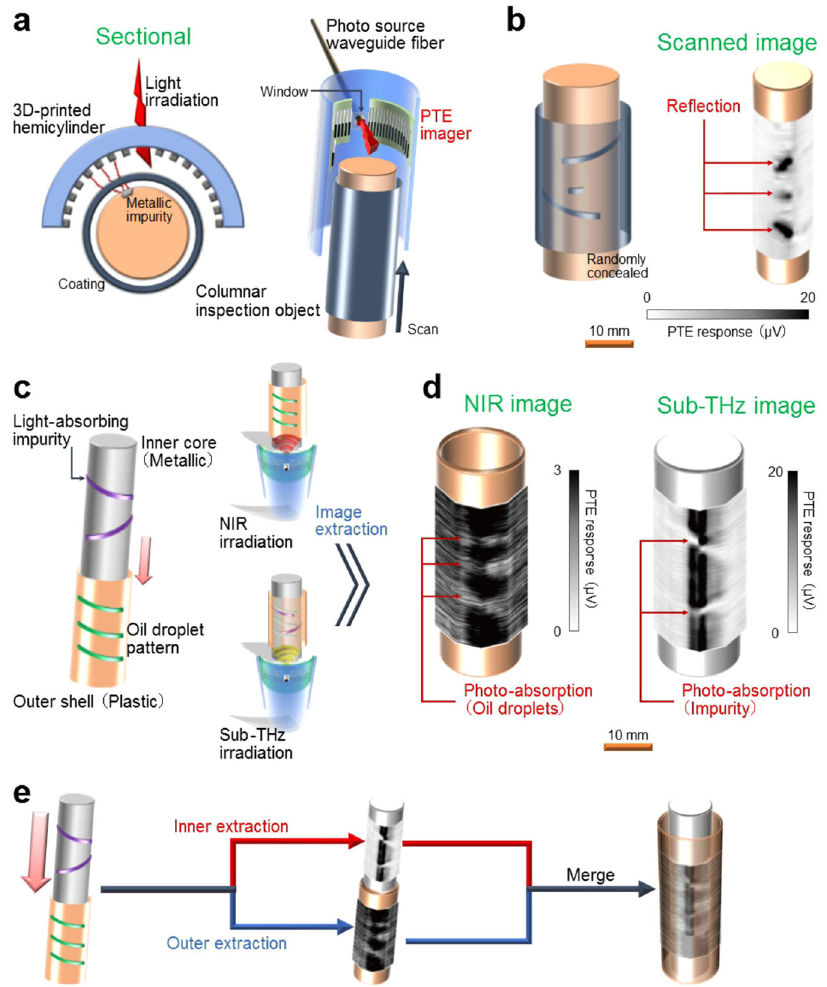
Fig. 2 Re fl ective multi-view stereoscopic capsule photo-thermoelectric (PTE) imager. a Schematic of the module and its fundamental operation mechanism. Operation of the re fl ective multi-view stereoscopic capsule PTE imager of the Methods section describes the corresponding detailed conditions. b Non-destructive re fl ective multi-view stereoscopic capsule photo-imaging inspection of a glass beverage bottle (in the sub-terahertz (sub-THz: λ = 1.15mm) frequency region) in which metallic impurities were concealed by an opaque coating. The impurities were visualised via detecting